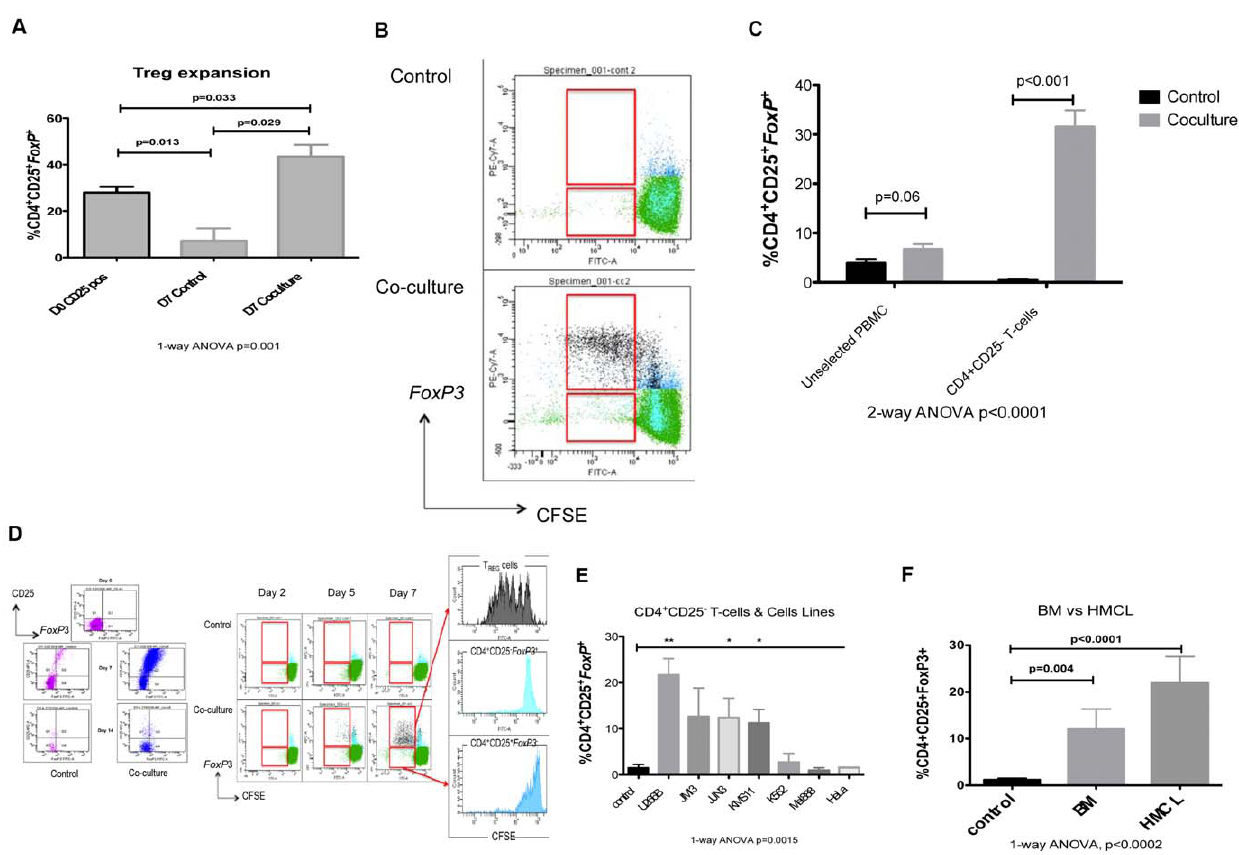
Figure 1. Regulatory T-cell induction by Myeloma tumour cells. A. The expansion of FoxP3 + CD25 + CD4 + natural T Reg cells, expressed as a percentage of CD4 + T-cells. T Reg cells were enumerated in the PB of healthy donors, after 7 days in CM and 7 days co-cultured with mitomycin C- treated U266B cells (n=4). Results represent all experiments, expressed as mean 6 SEM and analyzed using a 1-way ANOVA and student t-test. B. Expansion of nT Reg cells when co-culture with HMCL results from cell division, illustrated by a representative flow cytometry plot of CFSE dilution. C. The generation of FoxP3 + CD25 + CD4 + T-cells, expressed as a percentage of CD4 + T-cells, in a co-culture assay with mitomycin C-treated U266B cells (n=6) with varying starting populations: PB MNC, PBL CD25 depleted and CD4 + CD25 - T-cells. Results demonstrate that increased generation of tumour-induced regulatory T-cells (tT Reg cells) is seen with increasing purity of the seeded population. Results represent all experiments, expressed as mean 6 SEM and analyzed using a 1-way ANOVA and student t-test. D. Representative flow cytometry plots demonstrating the generation of FoxP3 + CD25 + CD4 + T-cells from CD4 + CD25 - T-cells through cell division of de novo generated FoxP3 + T-cells in a 7 day co-culture assay with mitomycin C-treated U266B cells. E. The generation of FoxP3 + CD25 + CD4 + T-cells, expressed as a percentage of CD4 + T-cells, in a co-culture assay of CD4 + CD25 2 T-cells (n=10) with mitomycin C-treated MM cell lines (U266B, JJN3, JIM3 & KMS11), an erythro-leukaemia cell line (K562) and non- heamatopoietic cell lines (Mel888 & HeLa). Results represent all experiments, expressed as mean 6 SEM and analyzed using a 1-way ANOVA and student t-test (**p , 0.001, *p , 0.01). F. The generation of FoxP3 + CD25 + CD4 + T-cells, expressed as a percentage of CD4 + T-cells, in a co-culture assay with fresh BM-derived myeloma plasma cells from patient samples (n=7). Results demonstrate that increased generation of tumour-induced regulatory T-cells (tT Reg cells) is seen with primary myeloma cells. Results represent all experiments, expressed as mean 6 SEM and analyzed using